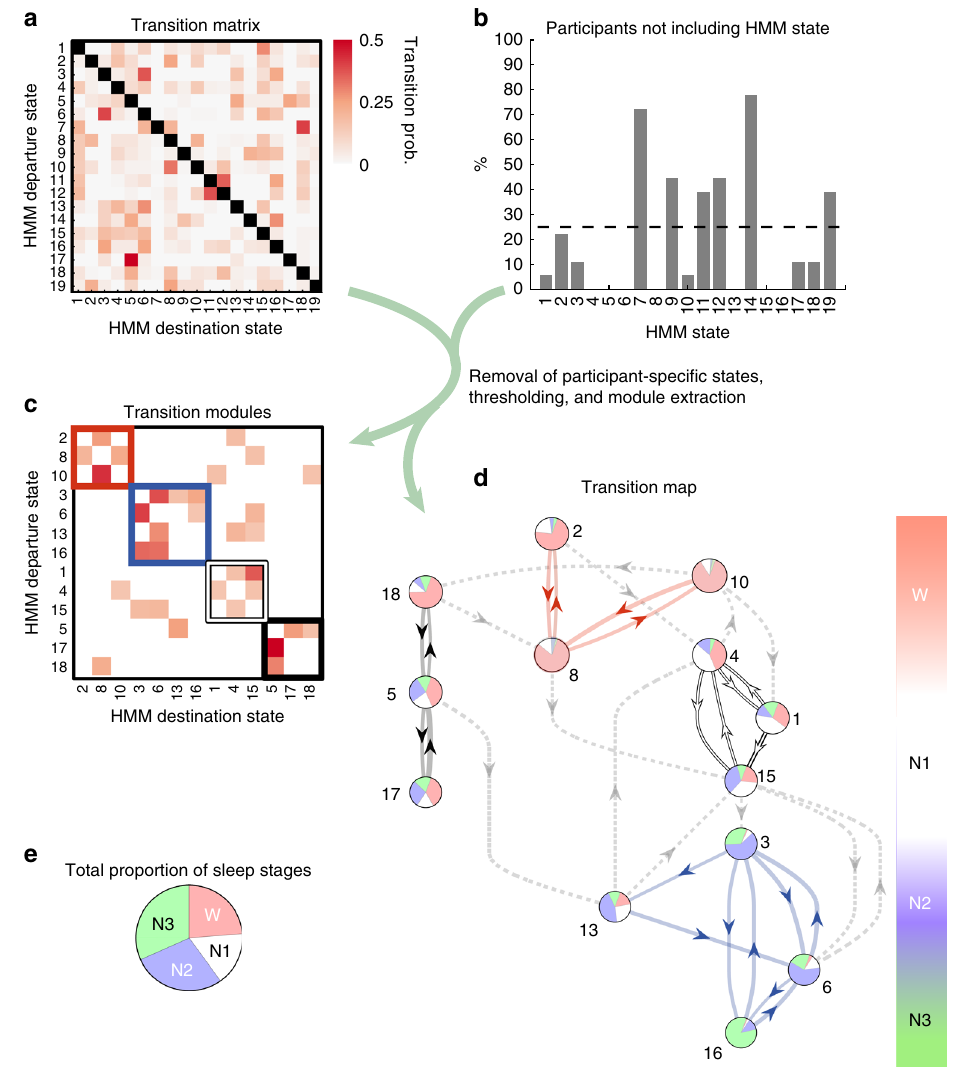
Fig. 4 Investigating modules of transitions between whole-brain network states. a The fi gure shows the 19 × 19 transition probability matrix of the HMM states calculated for the 18 participants that included all four PSG stages in their respective scanning session. This quanti fi es the likelihood of transitioning from any given state to any other state, yielding each matrix entry: transition probability from departure state to destination state. b A few HMM states were ‘ sporadic ’ and did not occur consistently across participants. HMM states not occurring in more than 25% of the participants were excluded. c The strongest transitions of the consistent HMM states were partitioned through a modularity analysis, and reorganised in a matrix according to the four resulting modules. d The transitions shown in c are presented as a transition map with each state depicted as a pie plot expressing its speci fi city for each of the four PSG stages. Arrows show the direction of the transitions with thickness proportional to the transition probability. The transitions describe a passage from HMM states with high activity during wakefulness in the top, further down through HMM states including more N1, and down to HMM states speci fi c to N2 and fi nally N3. Interestingly, wakefulness appears to be represented by two modules (red and black). Even though no individual HMM state showed clear speci fi city for N1 sleep, a module (white) is evident between HMM states with speci fi city for wakefulness and HMM states with speci fi city for N2 and N3 sleep. e Pie chart showing the total proportion PSG stages within the 18 participants. Transition prob.: transition